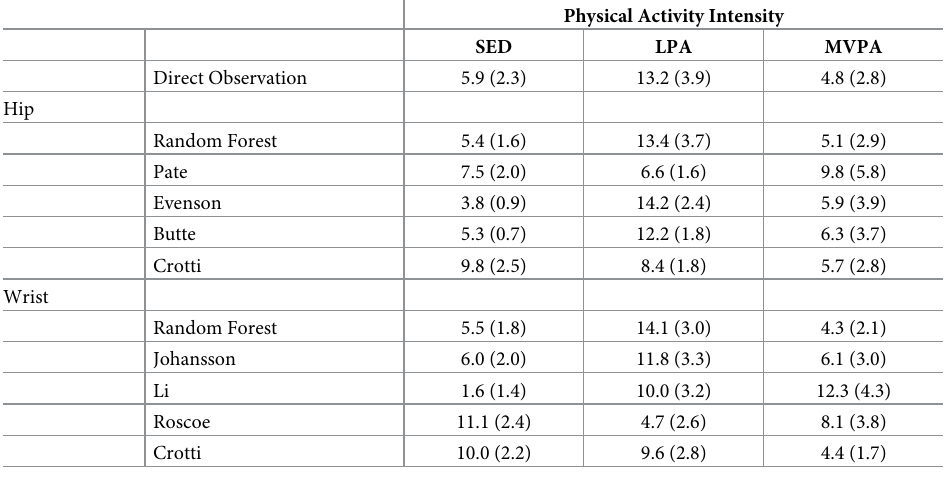
Table 3. Descriptive statistics for time in SED, LPA, and MVPA during the 20-min free play session as determined by direct observation, machine learning classifiers, and intensity-based